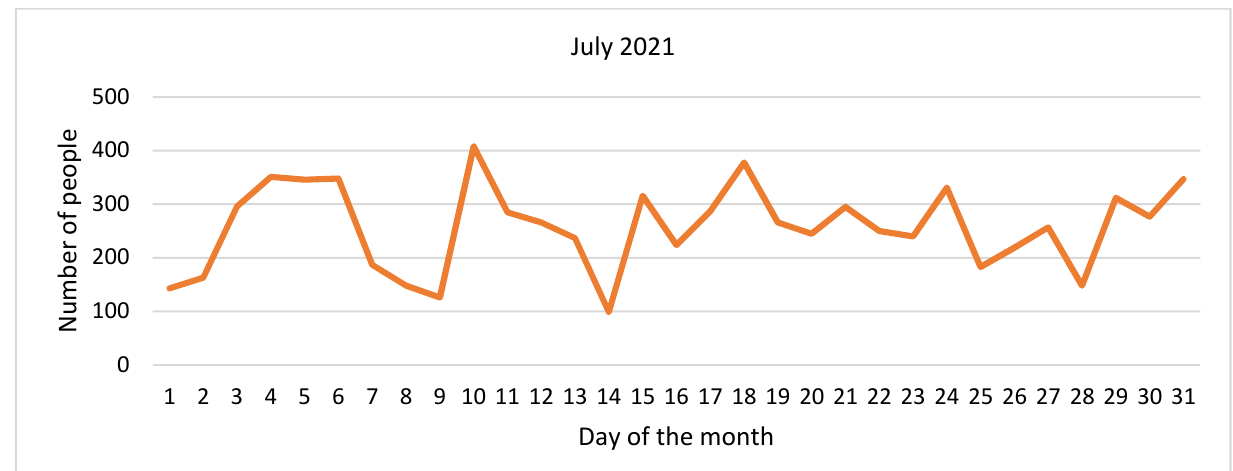
Figure 5. Recorded number of visitors per day in July in 2021.